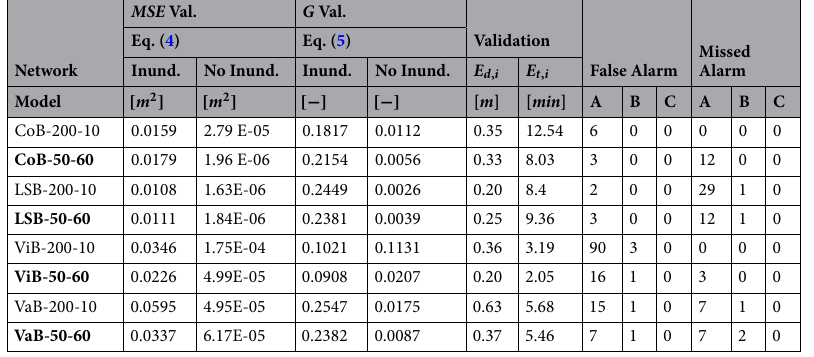
Table 4. Perfomance metrics for the best NNM at each location and sampling rate. Data highlighted in gray are the final NNM of each target buoy.